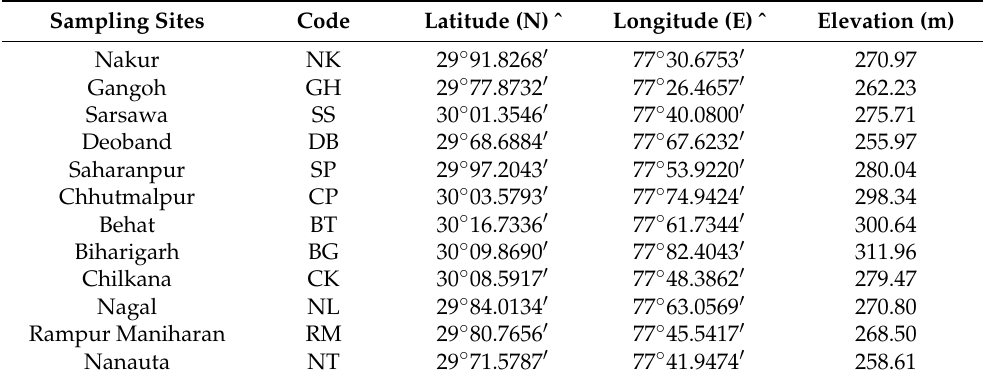
Table 1. Description of sites selected for the mango fruit ( M. indica ) sample collection from Saharanpur district, Uttar Pradesh,